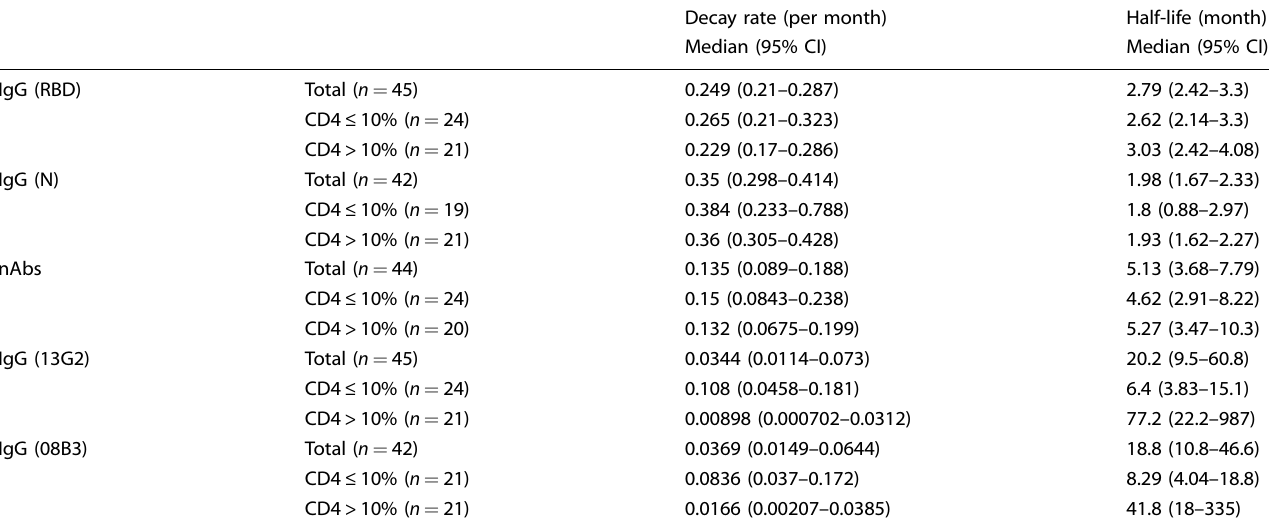
Table 1. Estimates of decay rate and associated half-life for different antibodies and CD4 + T-cell levels